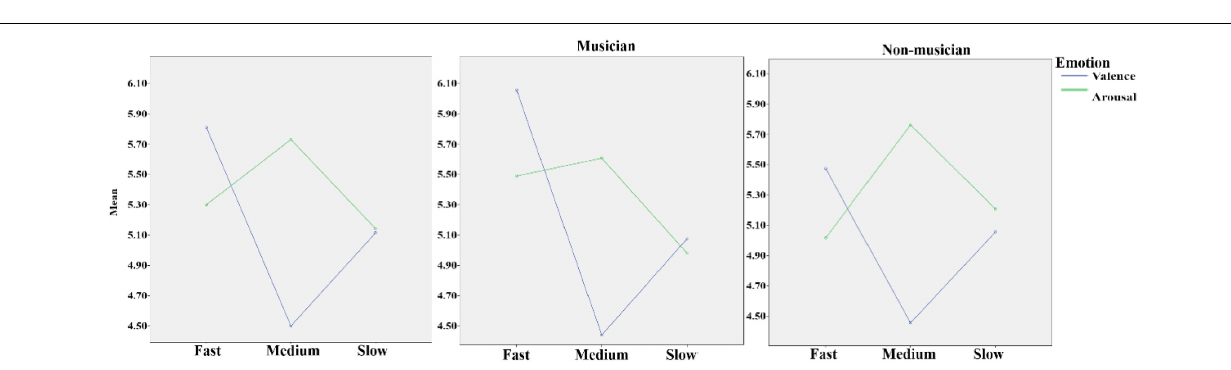
FIGURE 3 | The panel (Left) shows the mean scores of all participants’ valence and arousal to fast, medium, and slow music. The panel (Middle) shows the mean scores of musicians’ valence and arousal to fast, medium, and slow music. The panel (Right) shows the mean scores of non-musicians’ valence and arousal to fast, medium, and slow